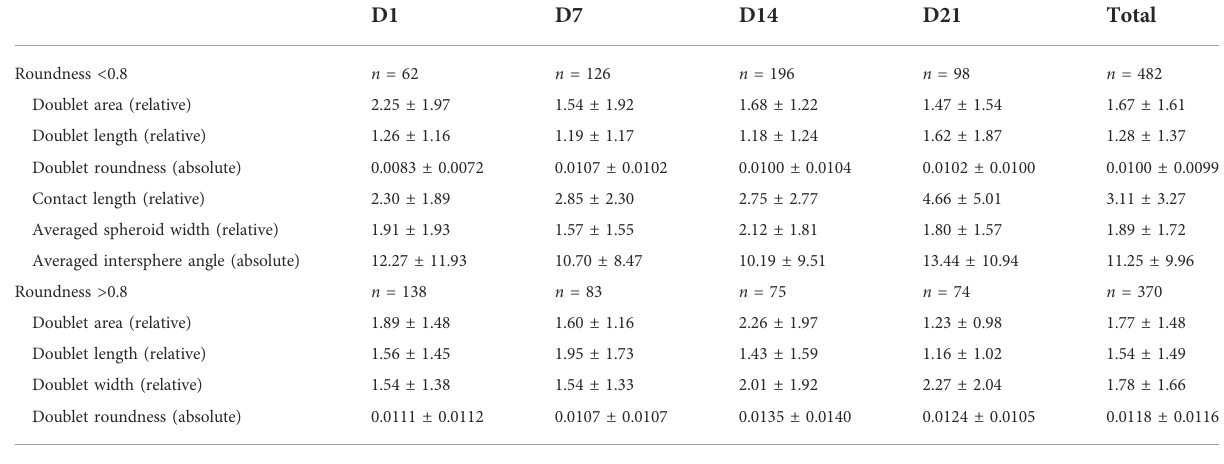
TABLE3Relativeandabsolute errorsobtainedfor thedifferent featureswith respecttomanualfeatureannotation.Thequanti fi cationwasseparated in function of the maturation time and the feature extraction procedure (before and after a roundness of 0.8), with the number of samples (N) indicated for each set. The results are represented as mean ± SD.